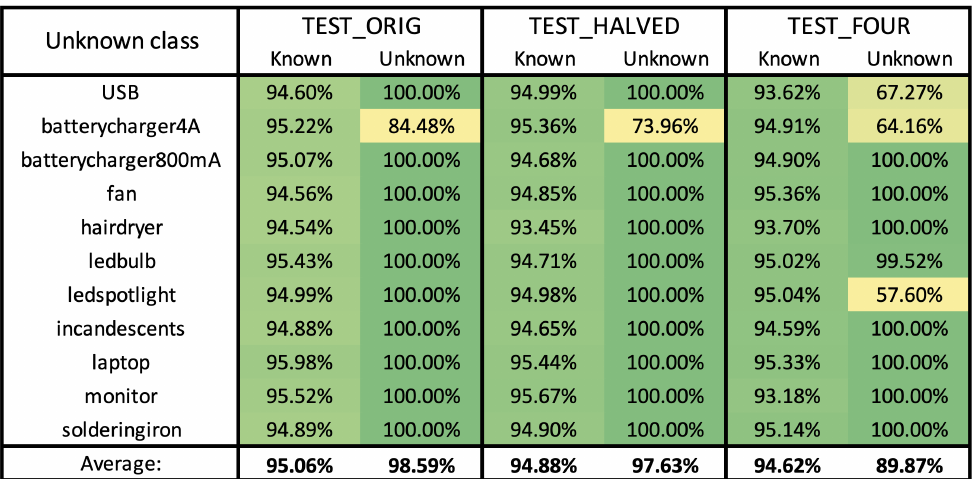
Figure 6. Average accuracy rates (of 10 runs) for CNN-based OpenMax open-set recognition using Weibull CDF fitted to the mean of the normed features introduced in Section 2.1. The Known columns show the average accuracy rate for classifying all known samples when the class in the left column was selected as the unknown. The Unknown column shows the average accuracy rate of classifying the 250 unknown samples (when the class in the left column was selected as the